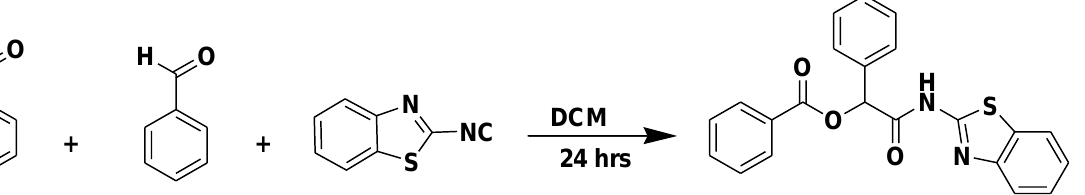
Figure 3. Synthesis of Passerini product using 2-isocyanobenzothiazole generated in situ . Table 4 . Synthesis of isocyanides via formamide dehydration utilizing the optimized reaction con- ditions with POCl 3 under solvent free conditions (see above) .